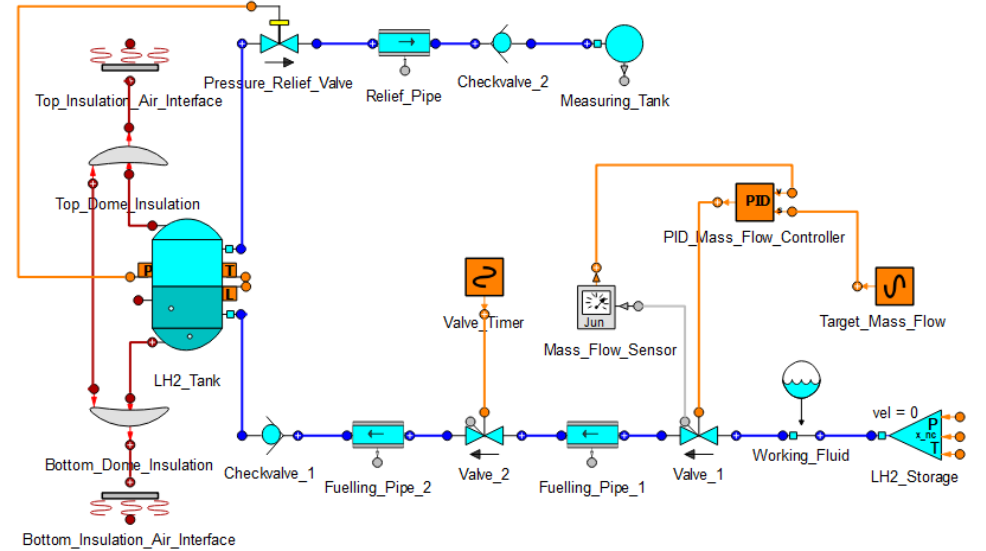
Figure 1. Fuelling Model (created in